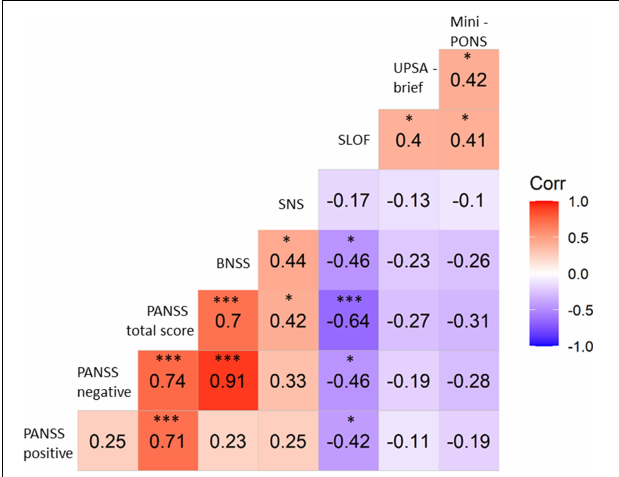
FIGURE 3 | Correlations between Mini-PONS total score and clinical/functional tests controlling for medication. PANSS, positive and negative syndrome scale; BNSS, brief negative symptom scale; SNS, self-evaluation of negative symptoms; SLOF, specific levels of functioning scale; UPSA-brief, University of California San Diego performance-based assessment; Mini-PONS, mini profile of nonverbal sensitivity; ∗ denotes significant correlations p -value < 0.05; ∗∗∗ denotes significant correlations p -value < 0.001.